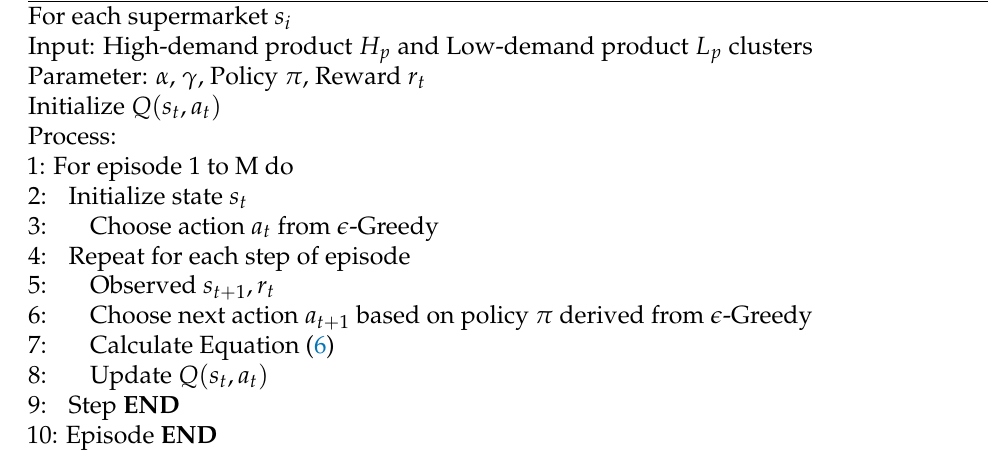
Algorithm 2 Product distribution decision making. For each supermarket s